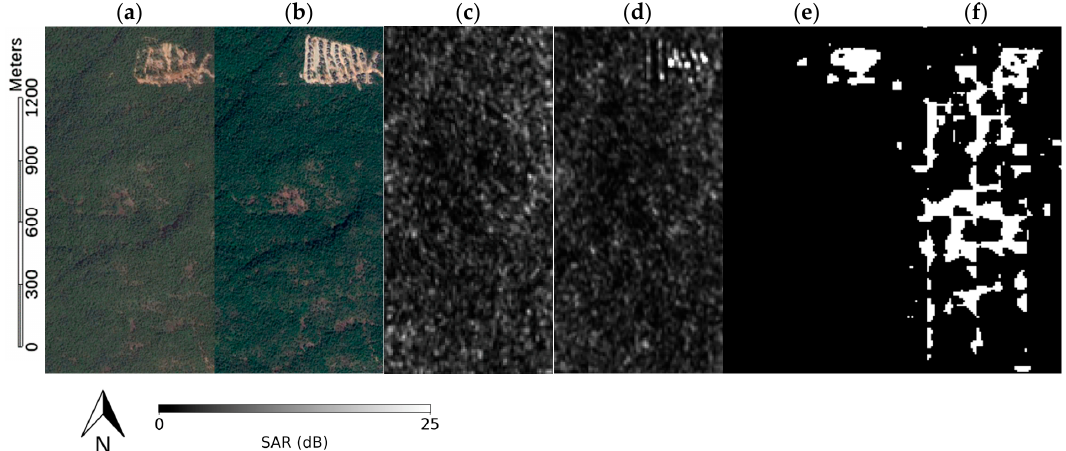
Figure 16. The result of the proposed model with an image from Sentinel-1 at 18°50’48.34”N 98°56’55.95”E. The size of each image is 0.8 × 1.75 km. ( a ) Time 1 optical data; ( b ) Time 2 optical data; ( c ) Time 1 SAR data ‘Copernicus Sentinel data [2015]’; ( d ) Time 2 SAR data ‘Copernicus Sentinel data [2017]’; ( e ) result of CORN; ( f ) result of U-net.